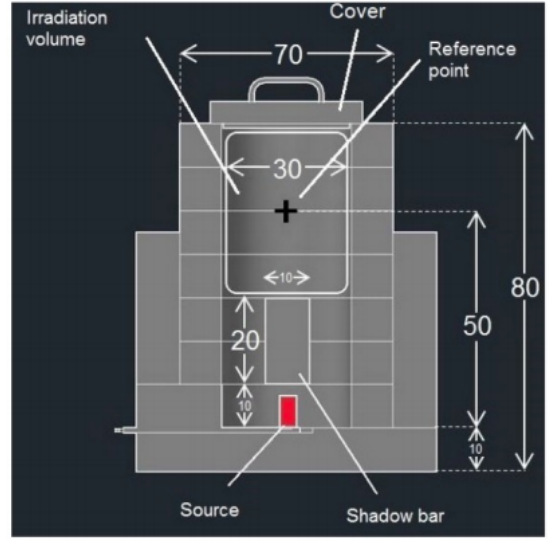
Fig. 5. Representation of the HOTNES setup with the radioactive source and the shadow bar in the middle The polyethylene blocks the neutrons to remove any hazard.